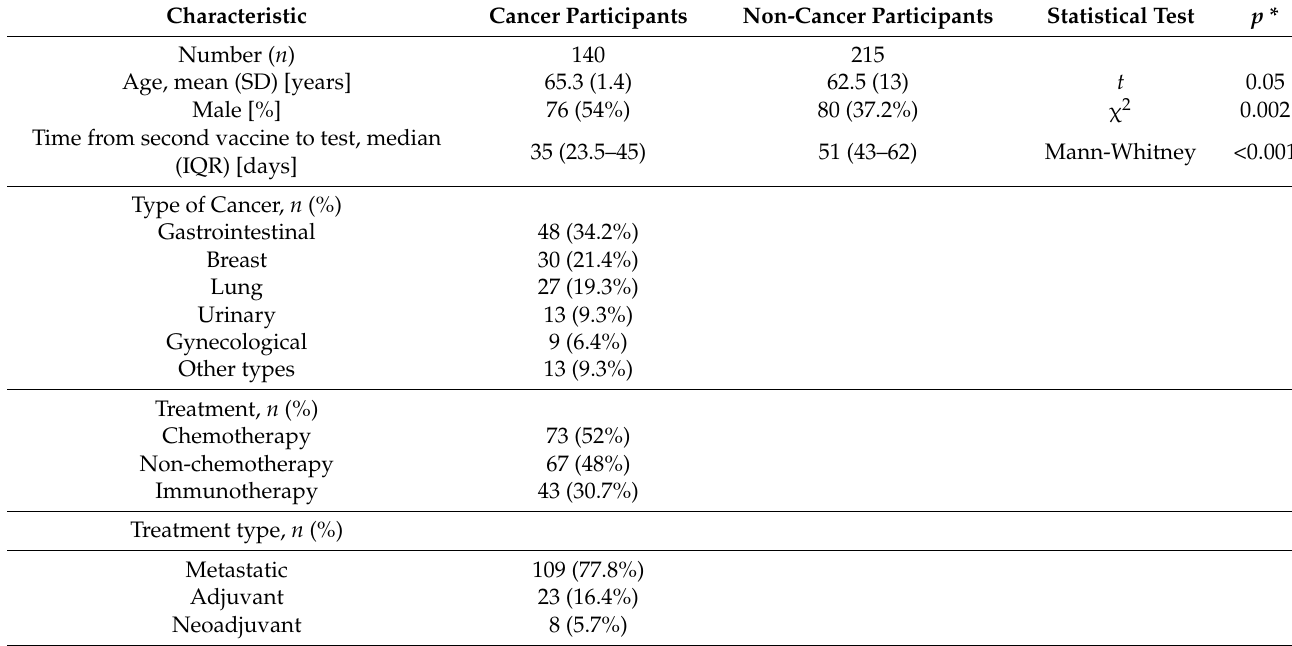
Table 1. Participants’